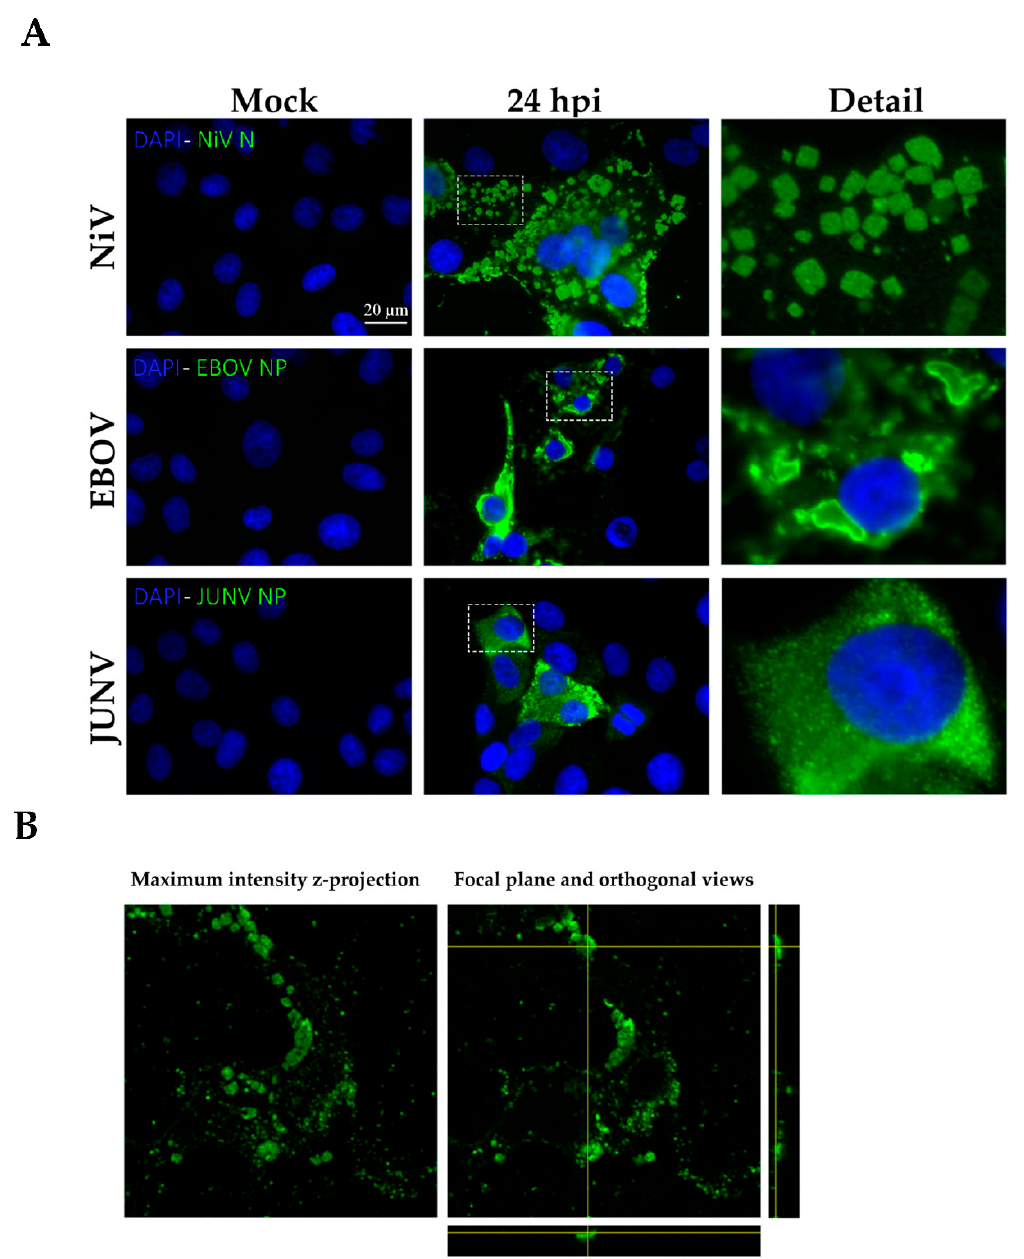
Figure 1. The ordered structure formation is virus-specific. ( A ) Microphotographs of Vero E6 cells infected with NiV, EBOV or JUNV. Viral nucleoproteins are immunolabeled in green, while nuclei are shown in blue; scale bar: 20 µm. In the right panel, magnifications of intracellular distribution of the nucleoproteins in infected cells correspond to the areas marked in white dotted boxes in the middle column. Three independent experiments were performed, in triplicate. ( B ) A z-stack of NiV infected cells, with NiV ordered structure formations, was generated. In the left panel: maximum intensity projection of the z-stack, where the maximum value of each focal plane is plotted. In the right panel: one focal plane of the z-stack and orthogonal views of the z-stack along the planes, shown in yellow, where a cross-section of a single ordered structure is depicted.